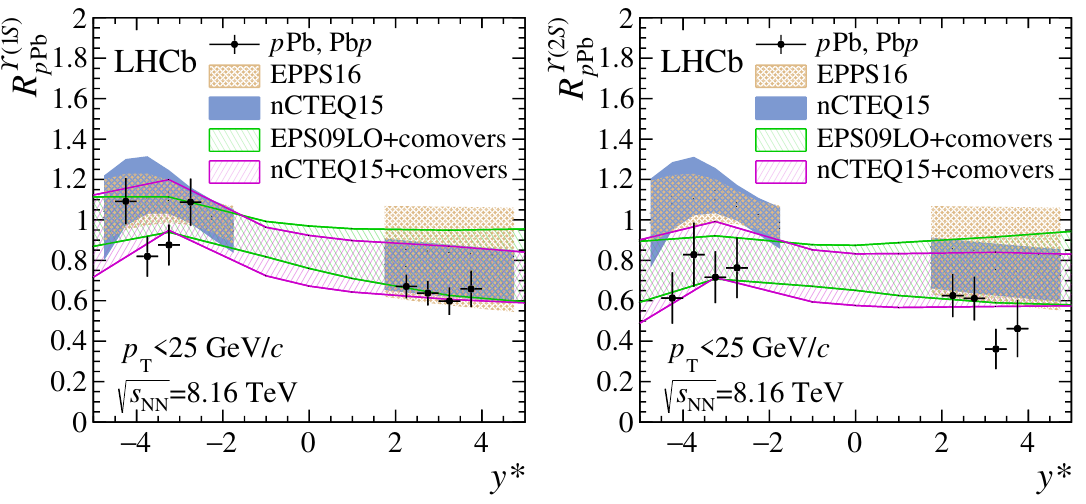
Figure 6 . Nuclear modi(cid:12)cation factors of the (left) (cid:7) (1 S ) and (right) (cid:7) (2 S ) mesons as a function of y (cid:3) integrated over p T for the forward and backward samples. The bands correspond to the theoretical predictions for the nCTEQ15 and EPPS16 nPDFs sets, and the comovers model as reported in the